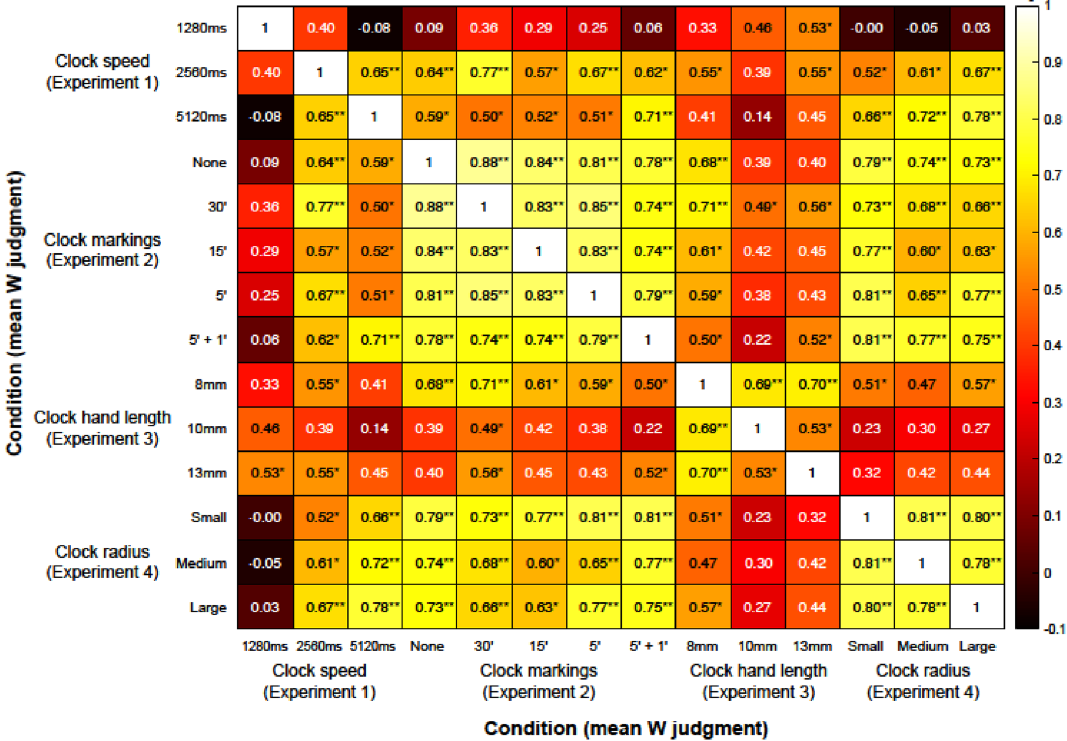
Figure 4. Heatmap containing the Spearman’s rho correlation coefficients between all mean W judgments per block per experiment. * and ** represent p < 0.013 (FDR) and p < 0.001,